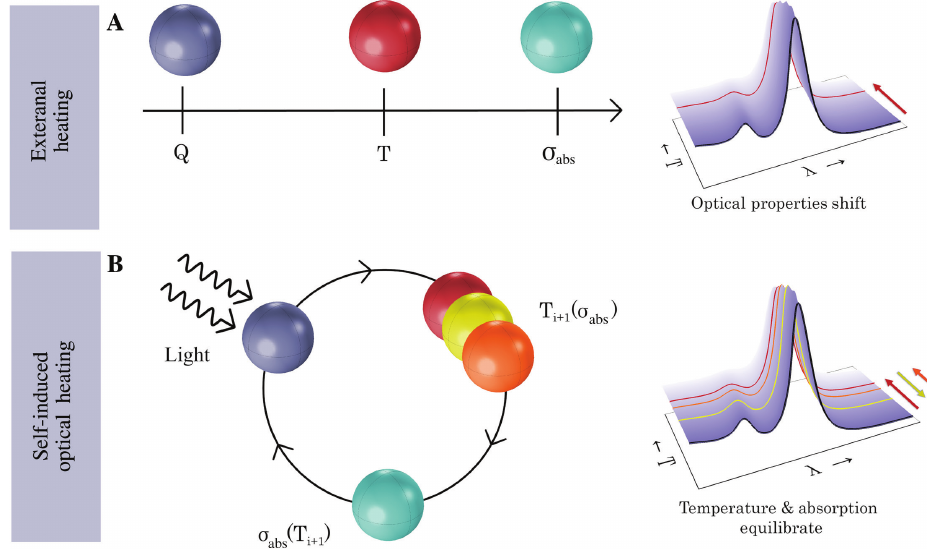
Figure 1: Conceptual representation of external heating and self-induced optical heating. Externally triggered (A) and self-induced (B) thermo-optical effects on the shift of the optical properties of dielectric nanoresonators. Panel (B) visualizes our recursive method that calculates a new absorption cross-section spectrum at every new temperature reached until the temperature and absorption equilibrate under continuous wave